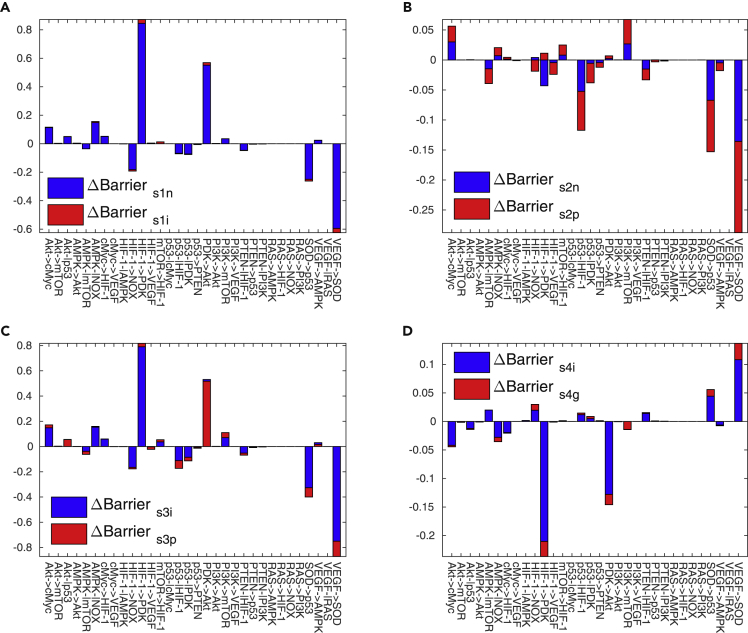
Global Sensitivity Analysis for the 32 Gene-Gene Regulations(A) The changes of the barriers from s1 to normal steady state and cancer intermediate state. (B) The changes of the barriers from s2 to normal steady state and cancer OXPHOS state. (C) The changes of the barriers from s3 to cancer intermediate state and cancer OXPHOS state. (D) The changes of the barriers from s3 to cancer intermediate state and cancer glycolysis state.X axis represents the 32 gene-gene regulations. Y axis represents the barrier changes. Each parameter is increased by 1% individually. ΔBarriers1n: the change of the barrier from s1 to normal steady state. ΔBarriers1i: the change of the barrier from s1 to cancer intermediate state. ΔBarriers2n: the change of the barrier from s2 to normal state. ΔBarriers2p: the change of the barrier from s2 to cancer OXPHOS state. ΔBarriers3n: the change of the barrier from s3 to normal state. ΔBarriers3i: the change of the barrier from s3 to cancer intermediate state. ΔBarriers4i: the change of the barrier from s4 to cancer intermediate state. ΔBarriers4g: the change of the barrier from s4 to cancer glycolysis state.